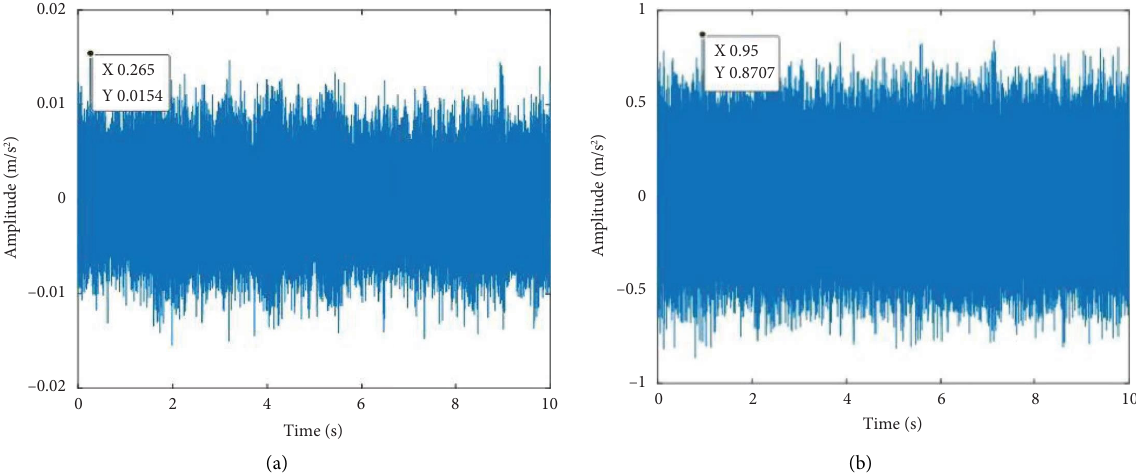
Figure 6: Time domain diagram of acoustic signals with no leakage and leakage at 0.4MPa. (a) Acoustic signal without leakage. (b) Acoustic signal with leakage.